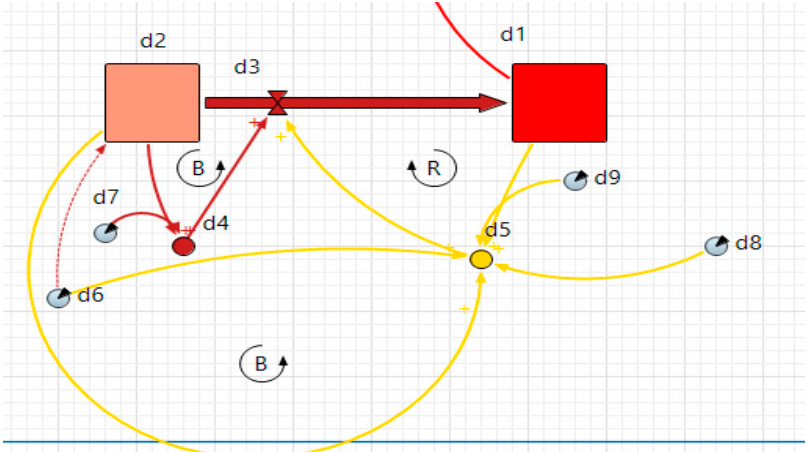
Figure 11. The model of demand on the market. Source: designed by authors.